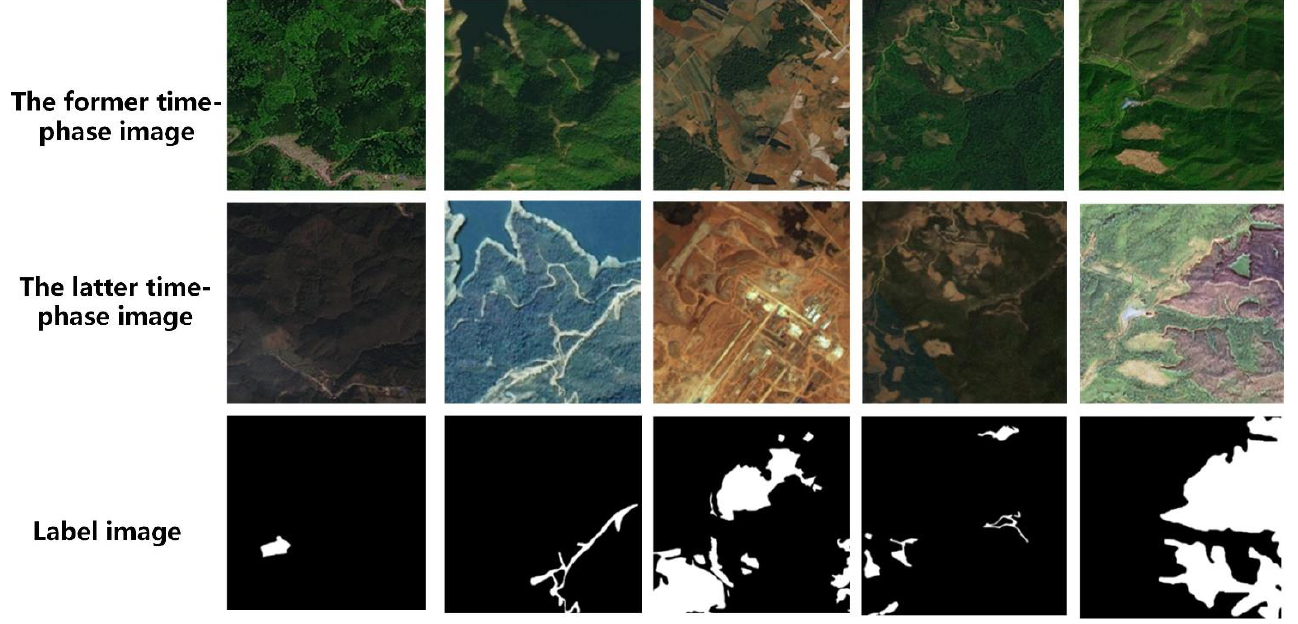
Figure 3. Deforestation detection dataset.